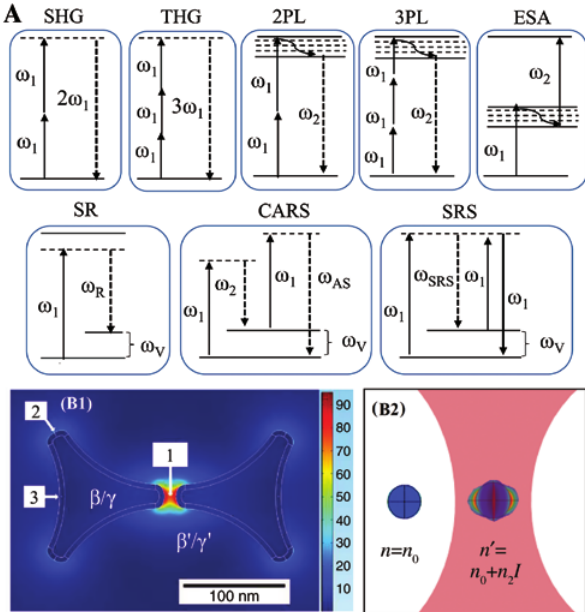
Figure 1: Schematics of electronic transitions in different non- linear processes and mechanisms of enhancement by plasmonic